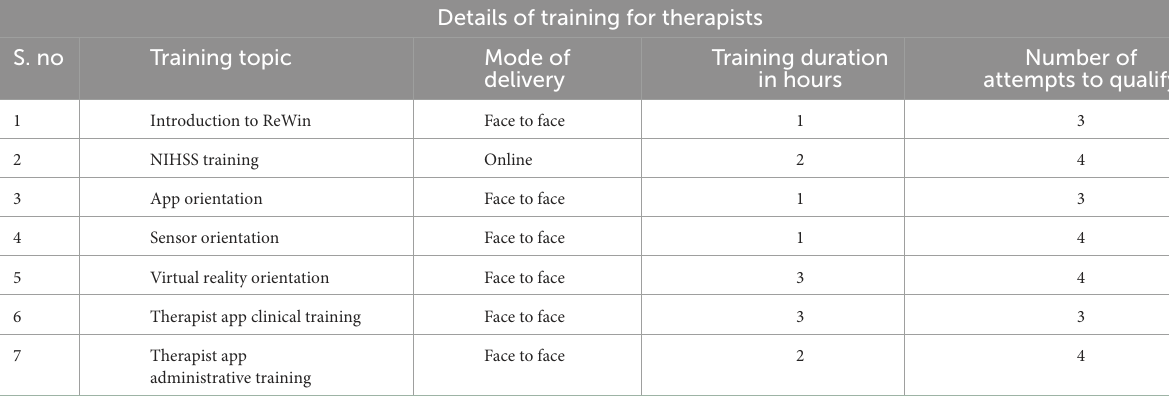
TABLE 1 Details of training for therapists.